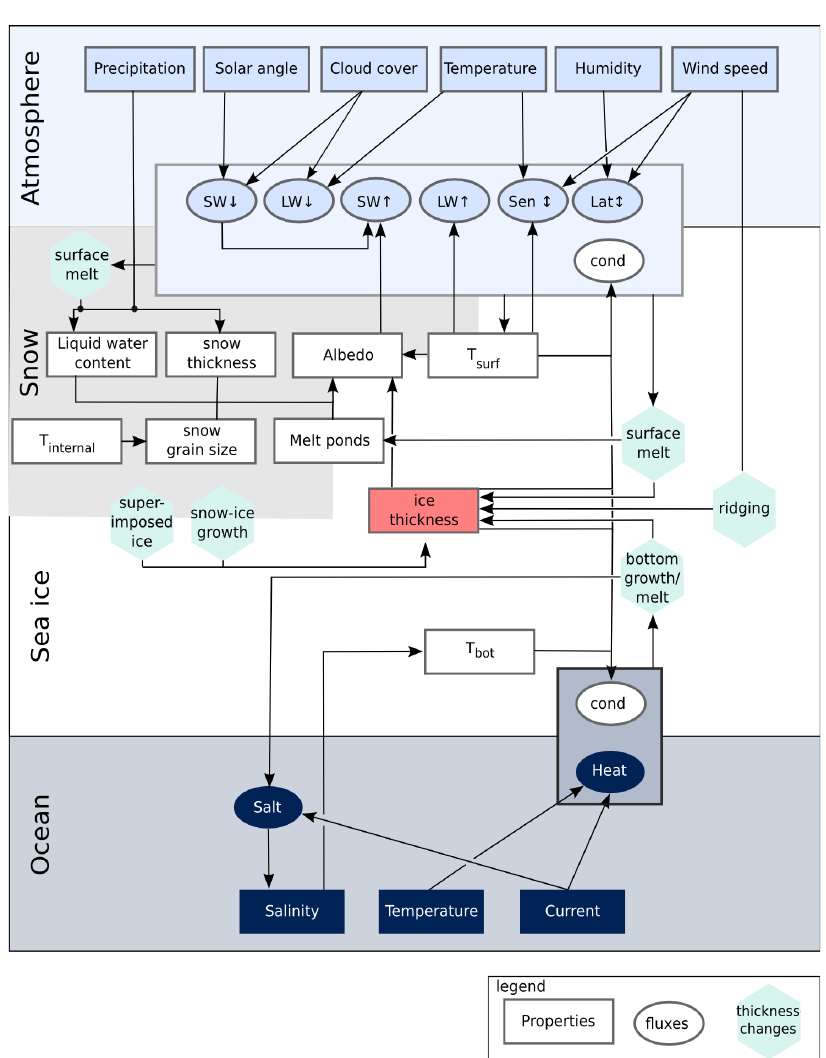
Figure 7. Schematic overview of some of the processes that influence and are influenced by the growth and melt of sea ice. Only the most important pathways of interaction are shown. SW is shortwave radiation, LW is long-wave radiation, Lat is latent heat flux, Sen is sensible heat flux, Cond is conductive heat flux in the ice, Heat is oceanic heat flux, Salt is oceanic salt flux, T bot is ice bottom temperature, and T surf is surface